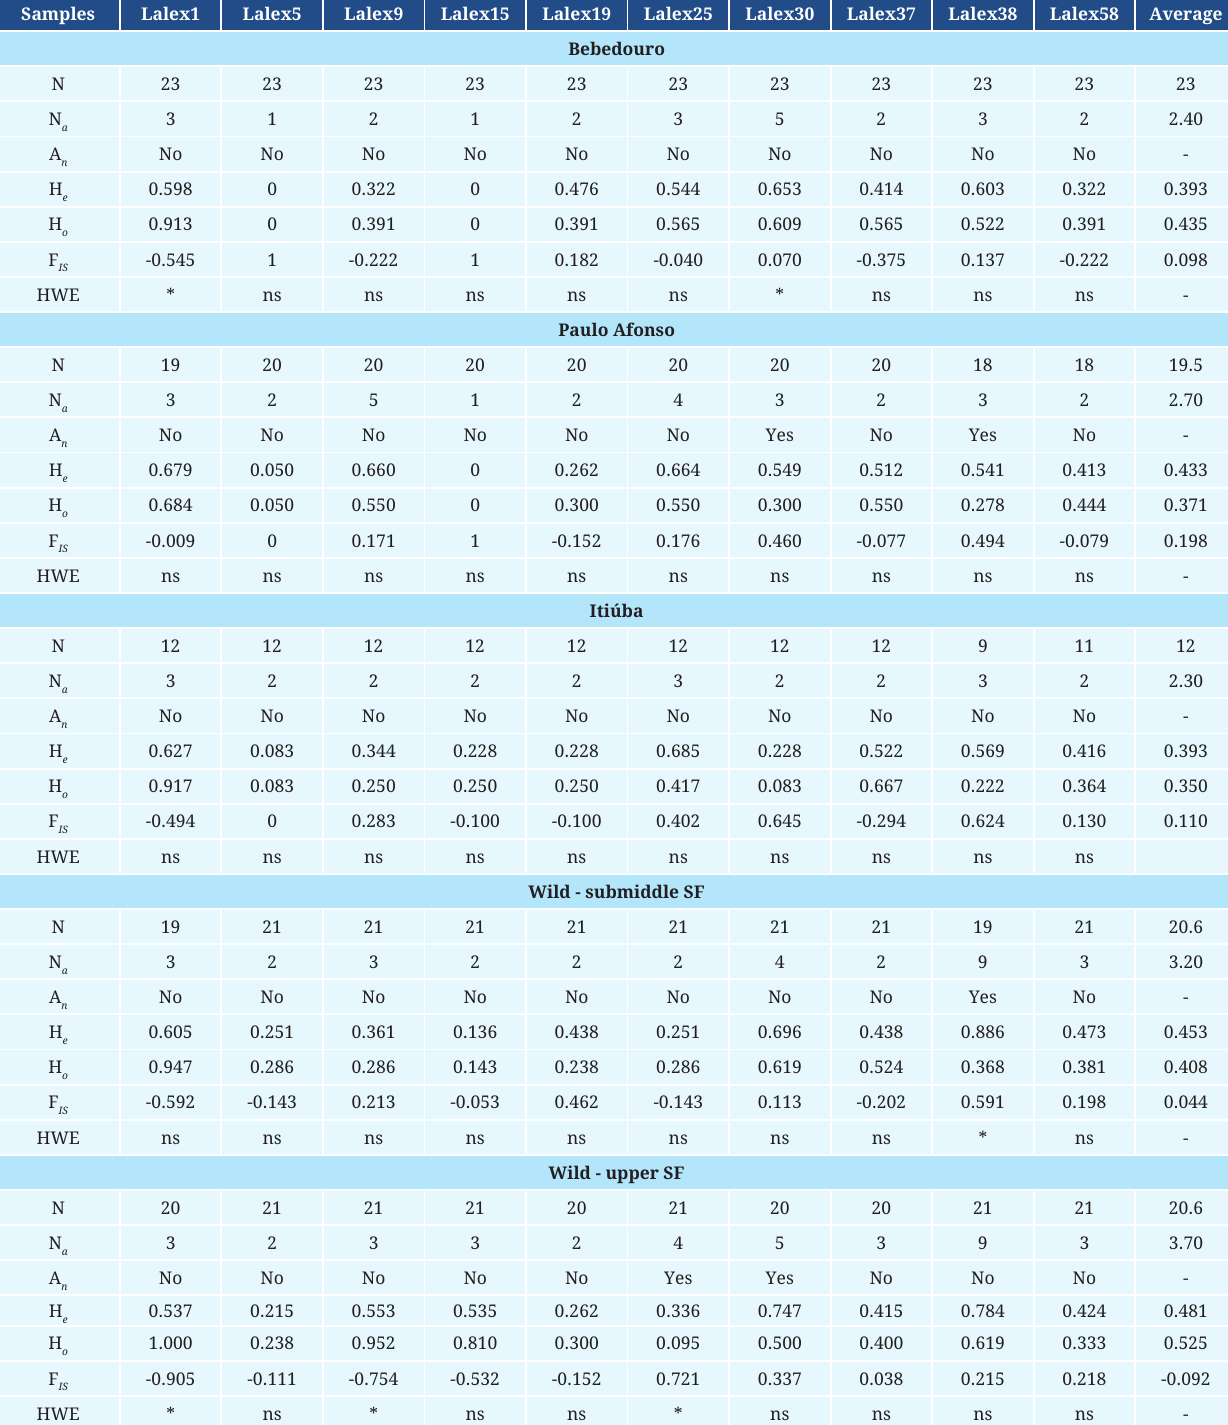
TABLE 2 | Genetic diversity for wild (upper and submiddle stretches of the São Francisco River) and captive (Bebedouro, Paulo Afonso, and Itiúba) Lophiosilurus alexandri samples . N = number of individuals, N observed heterozygosity, F = inbreeding coefficient, HWE = Hardy-Weinberg equilibrium deviation, ns = not significant, * p <0.05, adjusted IS by Bonferroni correction, K =